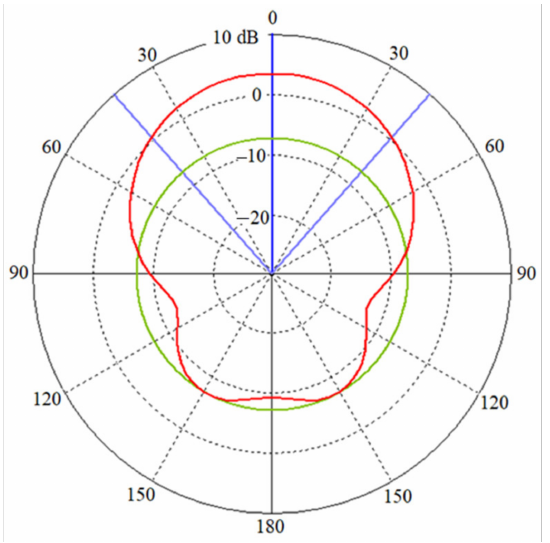
Figure 13. Simulated radiation pattern H-plane at 5.0